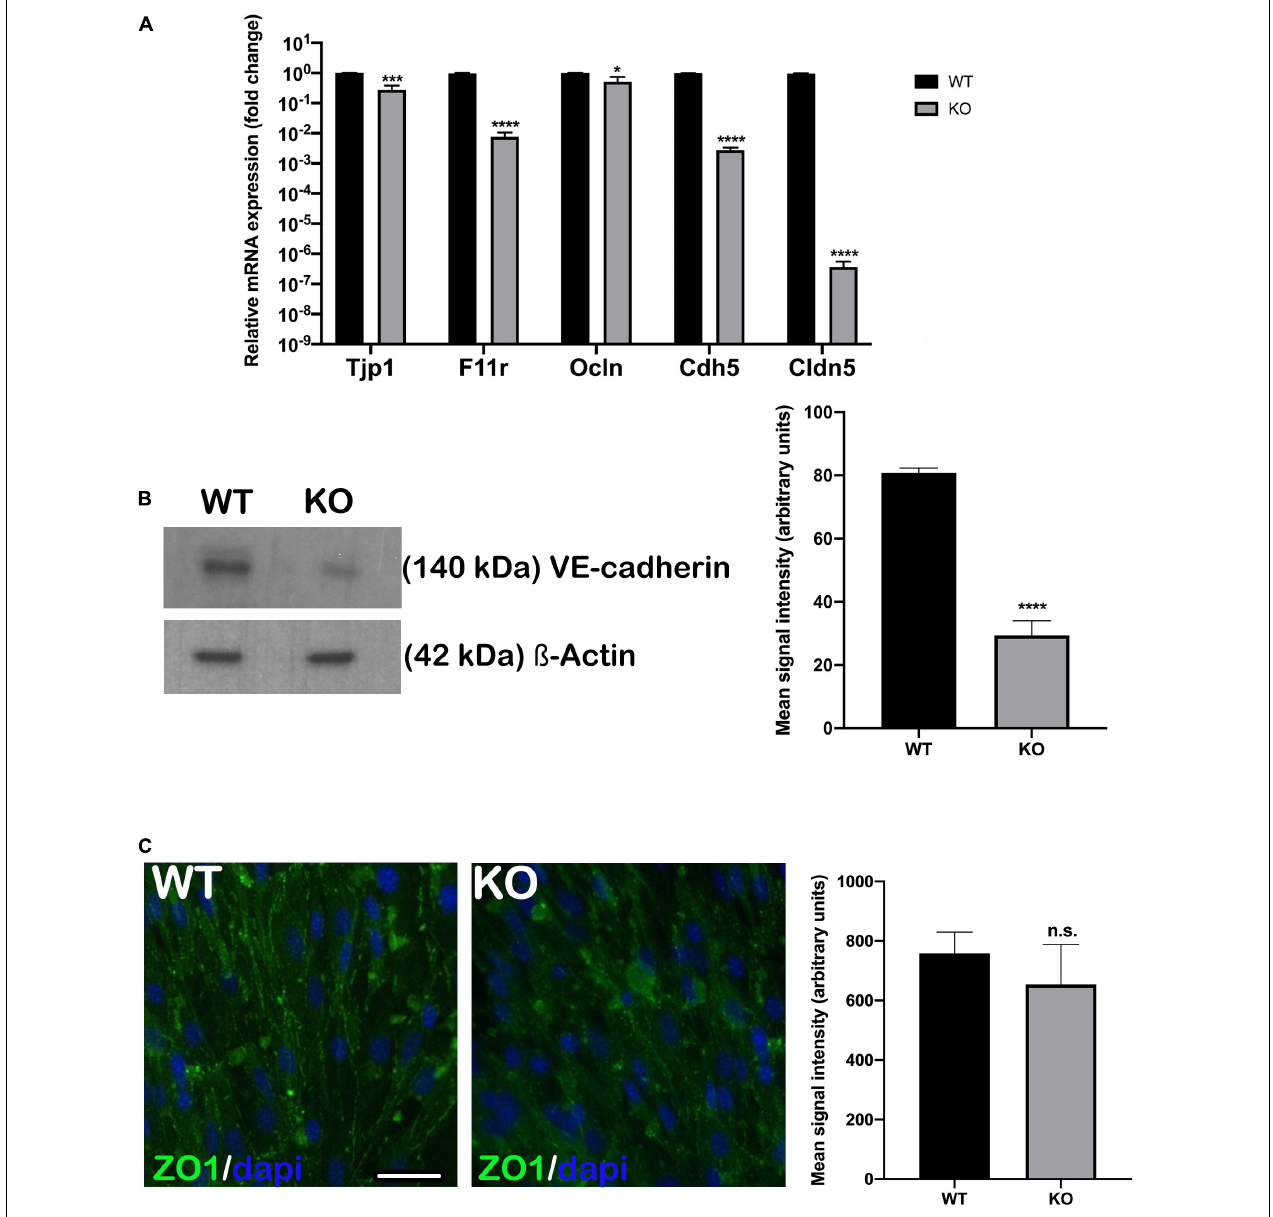
FIGURE 1 | Endothelial junctional gene expression was downregulated in Nhe6 -knockout cells. (A) Relative expression of genes that encode the major adherens and tight junction proteins, Tjp1 , F11r , Ocln , Cdh5 , and Cldn5 are compared between Nhe6 -knockout (KO) and wildtype (WT) cells. The overall expression levels of adherens and tight junction-related genes were significantly lower in KO than in WT cells, and the most prominent downregulations were in Tjp1 , Cdh5 , and Cldn5 . Data represent the mean (SD); ( n = 3). (B, left panel) Representative western blot image showing decreased VE-cadherin protein presence in Nhe6 -knockout EC cell lysate. (B, right panel) Western bolt signal quantification. Each endothelial cell culture was obtained from three mice per phenotype and experiment, and individual experiments performed three times ( n = 3); Data represent the mean (SD); * P < 0.05, *** P < 0.001, **** P < 0.0001. ß-actin was used as a loading control. (C, left panel) Immunostaining shows the expression of tight junction protein, ZO1 (green), in WT and KO endothelial cells. (C, Right panel) ZO1 immunofluorescence signal quantification. Samples from five mice were pooled per phenotype and experiment; ( n = 3); Scale bar, 50 µ m. Data represent the mean (SD); ( n = 3); n.s., not